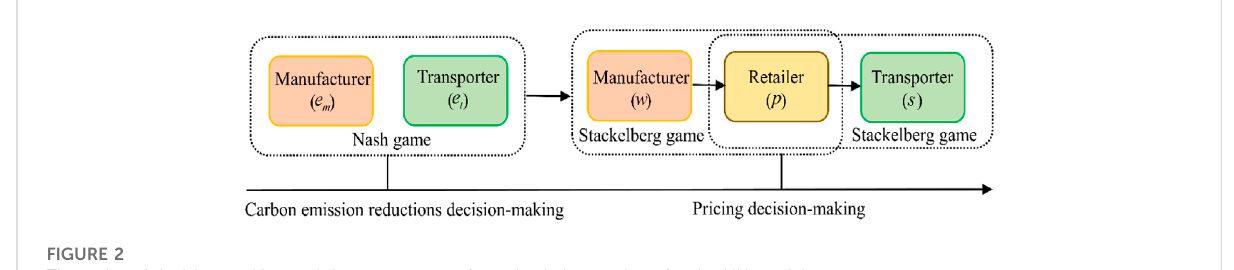
FIGURE 2 The order of decision-making and the game types of supply chain members for the NN